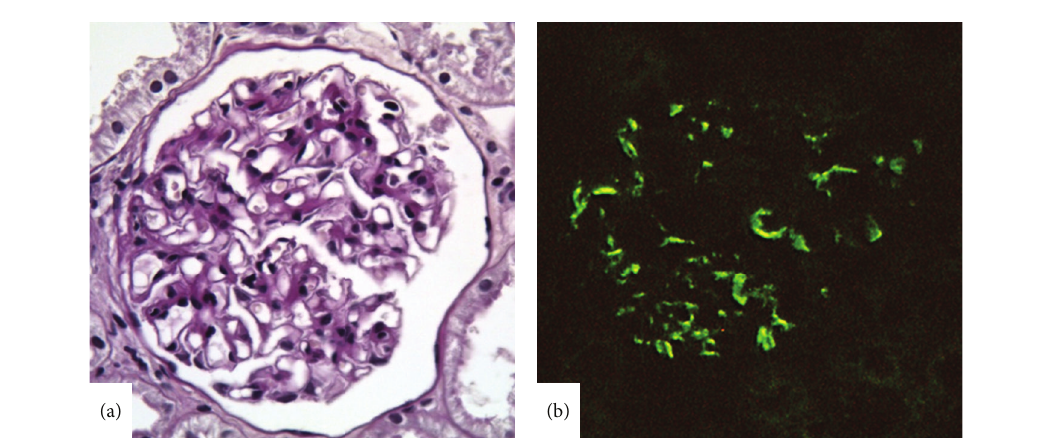
Figure 1: Lupus nephritis class I. (a) A normal appearing glomerulus with no mesangial alteration (periodic acid-Schiff stain, × 400). (b) Mesangial IgG deposition by IFM ( ×